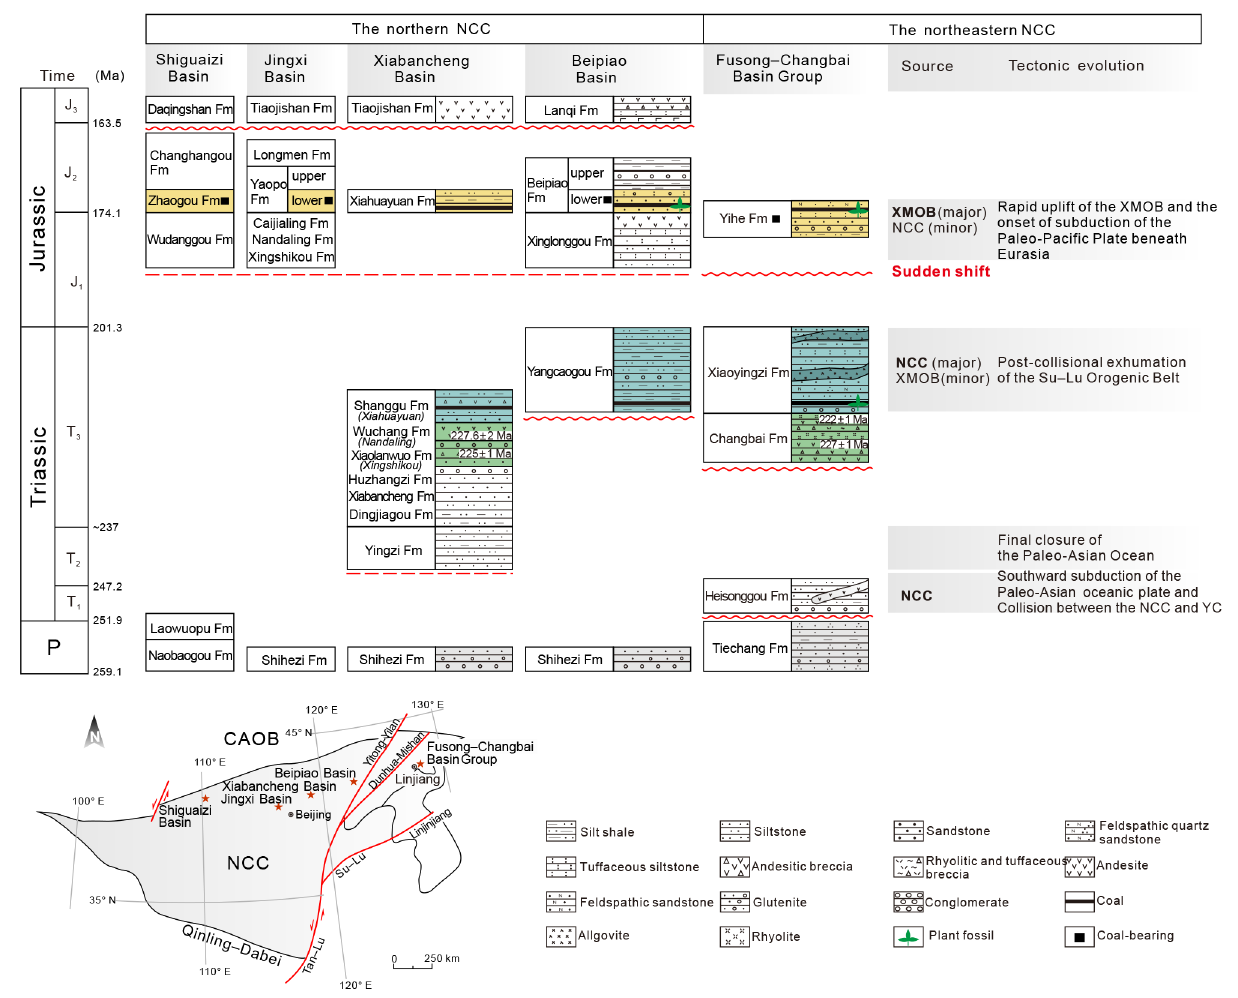
Figure 11. Correlation between the early Mesozoic stratigraphy of the northern and northeastern NCC (the stratigraphic sequence of the northern NCC is from Meng et al.,